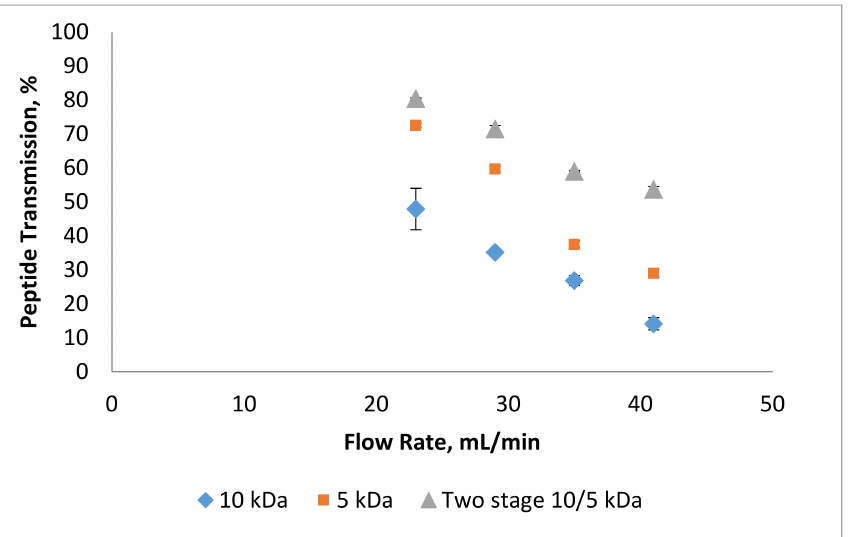
Figure 4. Peptide transmission at different feed flow rates for single and two stage UF